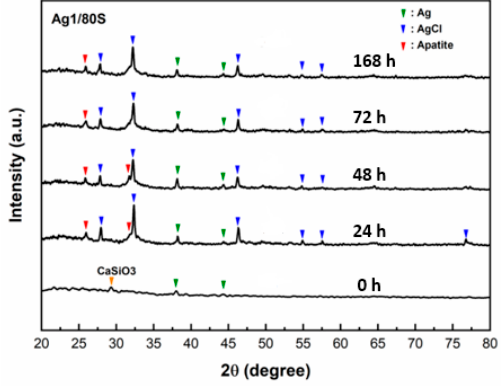
Figure 2. XRD patterns of Ag1 / 80S after immersion in PBS for di ff erent times.